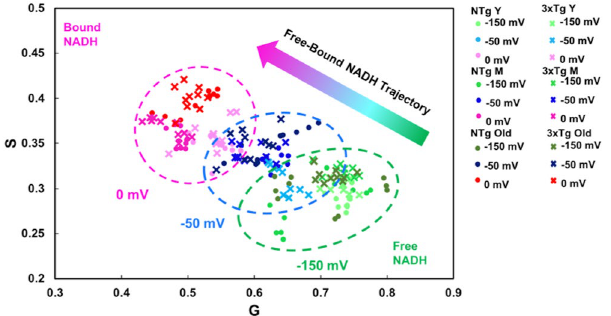
Figure 2. Mitochondrial NADH shifts toward more bound NADH with oxidative states and toward more free form in response to the imposed external reductive treatment (female neurons). Each dot or cross point represents one neuron, the average of mitochondrial regions (ROIs) from a single NTg or 3xTg-AD neuron (n = 10 neurons/age/genotype/redox state = 180 points). The dashed ellipses are manual groupings by imposed redox state. Note that mitochondrial free/bound NADH re-distributes in response to the manipulated external Cys/CySS redox states from reductive ( − 150 mV) to oxidative (0 mV) in both genotypes and three ages are shown by the colored arrow (ANOVA for G, F(2, 179) = 547, p < 0.001; for S, F(2, 179) = 356, p <